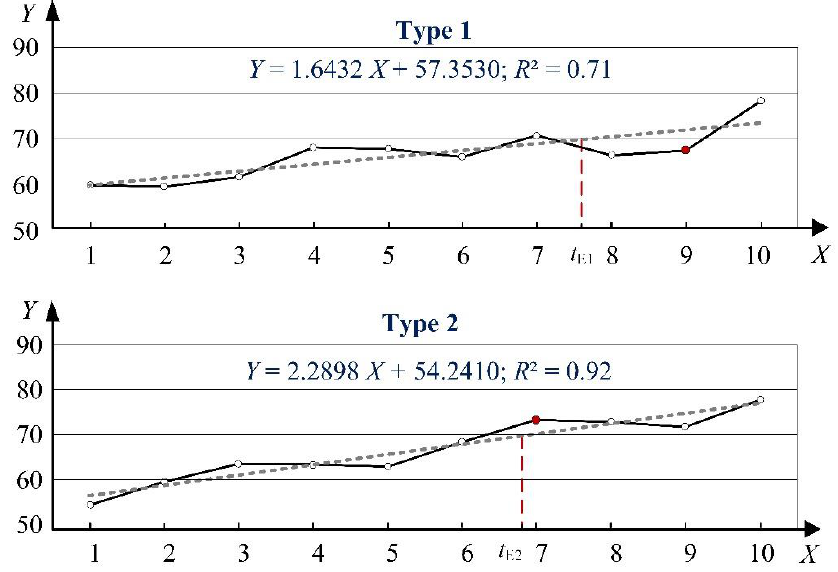
Figure 3. Dependability of specific costs [EUR/wh] of a lifetime ( Y -axis) and years ( X -axis).